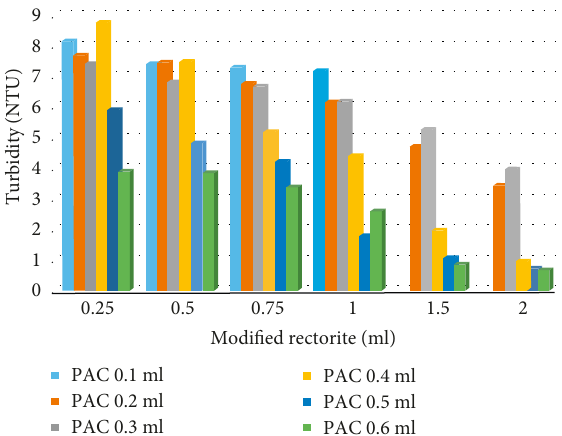
Figure 8: Turbidity of tap water treated with 1 drop of chitosan, polyaluminum chloride, and modified